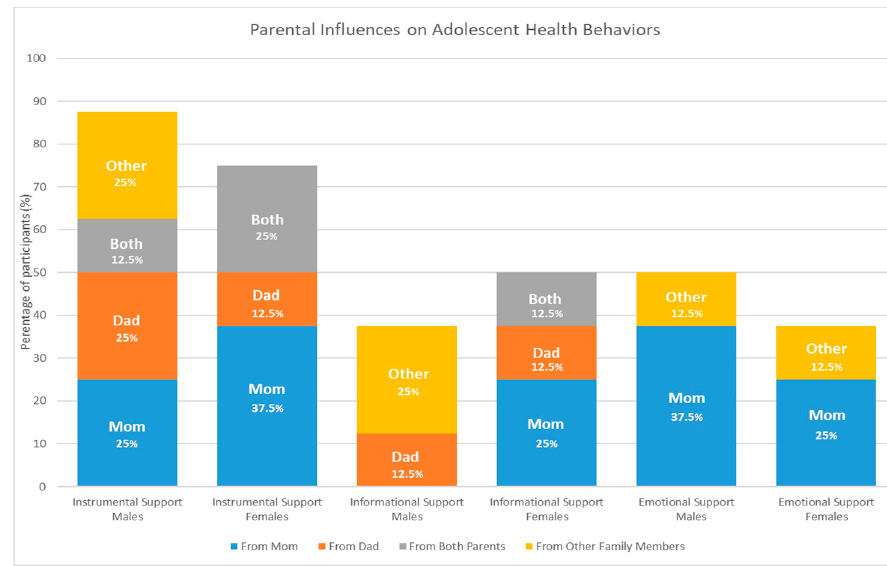
Figure 2. Adolescent perceived family social support for health behaviors.